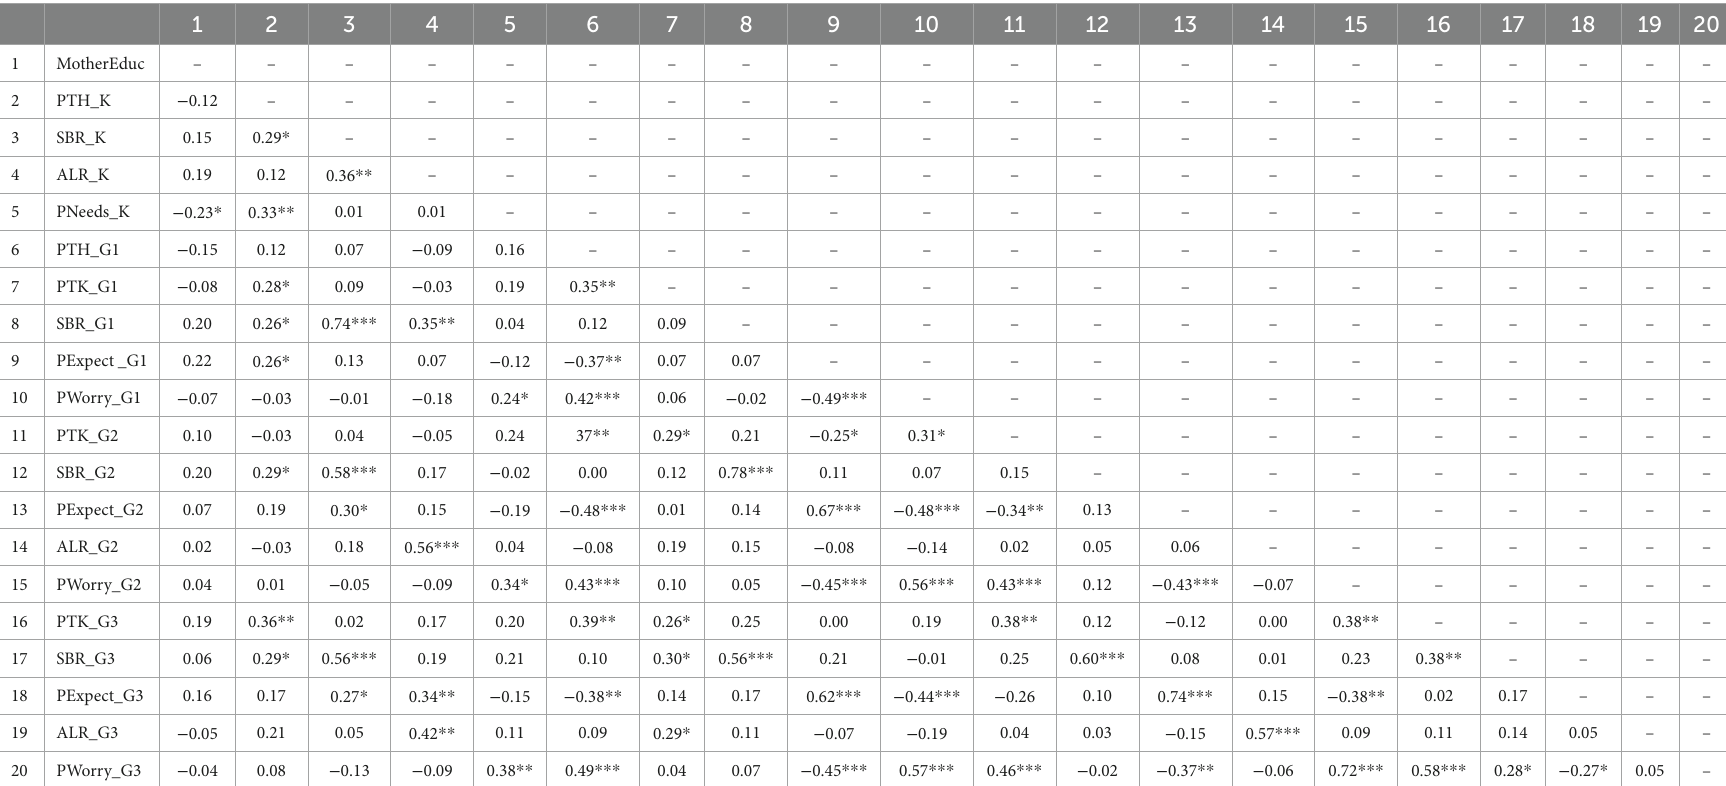
TABLE 2 Correlation between parent